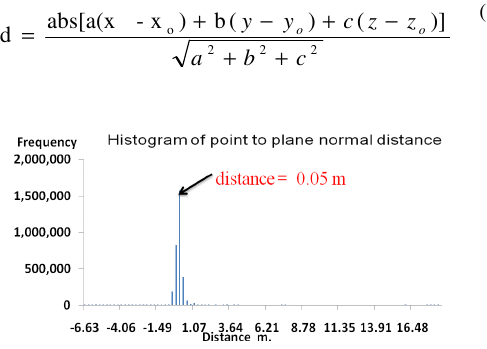
Figure 5. Histogram of point to plane normal distance